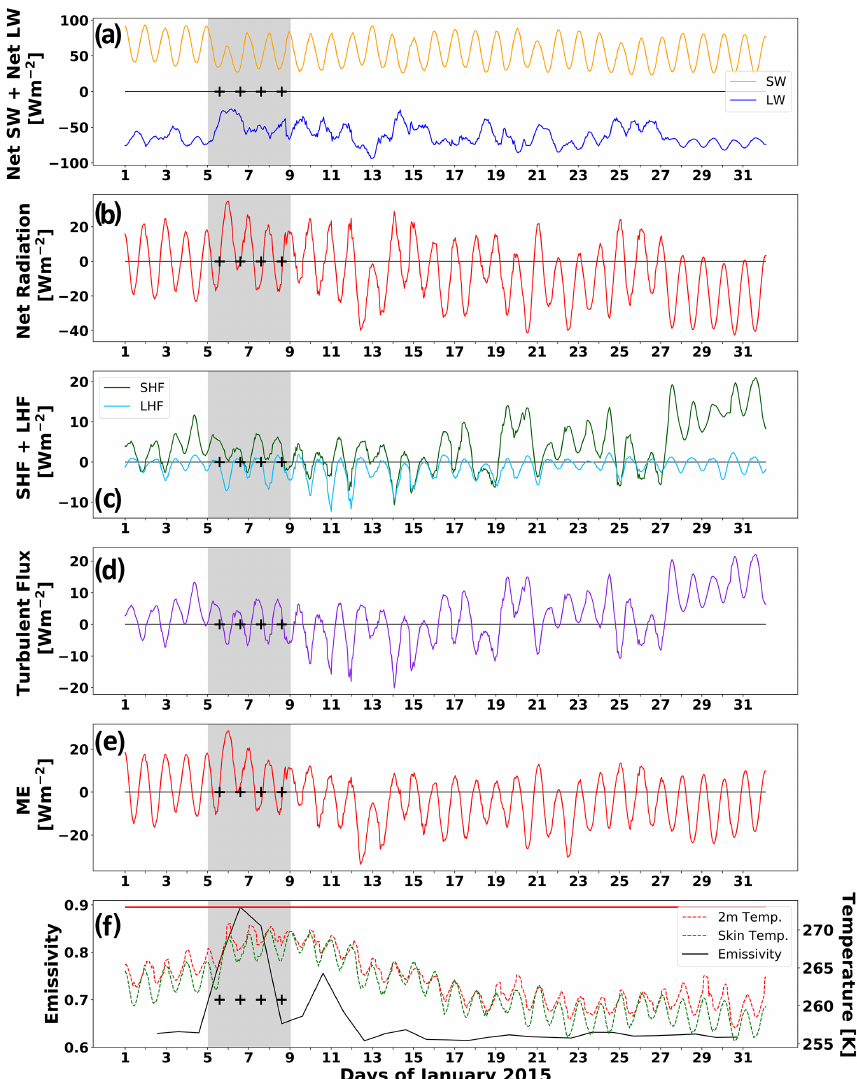
Figure 4. Time series of the hourly ME components over the Siple Dome region throughout January 2015 from ERA5: (a) individual net SW and LW fluxes; (b) total net radiative flux (SW + LW); (c) individual SH and LW fluxes; (d) net turbulent flux (SH + LH); (e) total ME; (f) skin temperature (green), 2m air temperature (red), and sampled 99th percentile emissivity from Fig. 3b (black). The horizontal red line in panel (f) is at 273.15K. The shaded region denotes the melt period of interest. Black crosses denote the satellite evening overpass